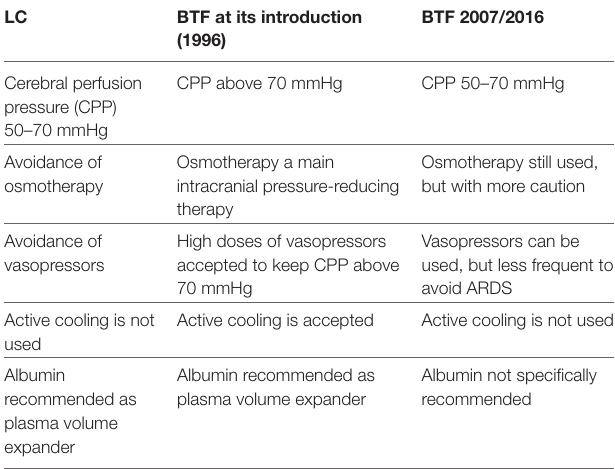
TABLe 1 | Examples of components where the BTF guideline has approached or deviated from the Lund concept